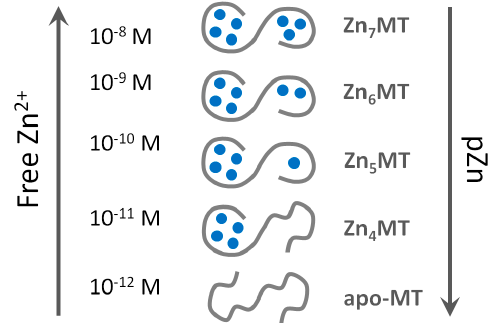
Figure 2. Structural polymorphism of human zinc metallothionein as a function of cellular free Zn 2+ (pZn) concentrations.